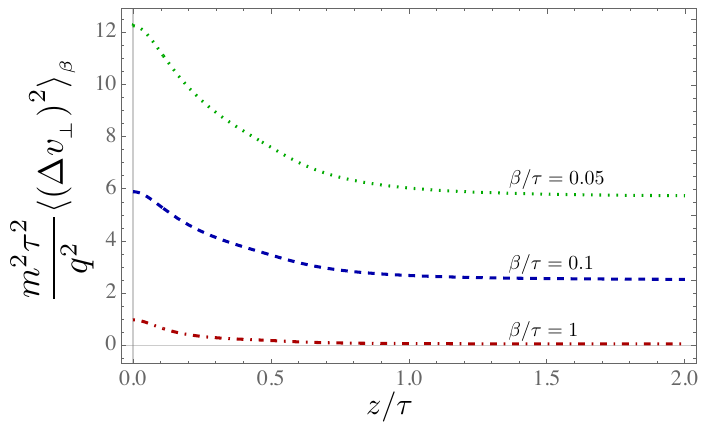
Figure 9 . Behaviour of the perpendicular component of the dispersion near the wall. Notice that, di(cid:11)erently from the parallel component, now the magnitude of the dispersion when z on the temperature, for a same transition duration. In this (cid:12)gure we choose (cid:28) s =(cid:28) = 0 : 1.